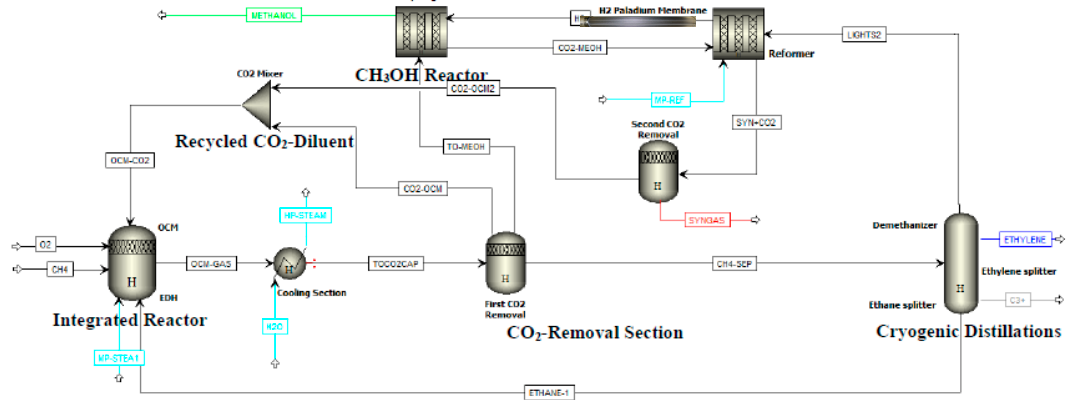
Figure 2. The process flowsheets of integrated OCM process structures simulated in Aspen (the unit names are according to Supplementary Table S1).